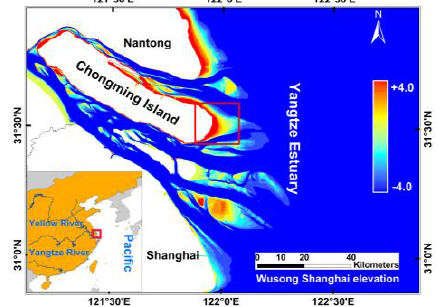
Figure 1. The location of the study area 2.1.2 Data set: The Landsat series of satellite images has a time span of nearly 50 years, with a wide map size and moderate